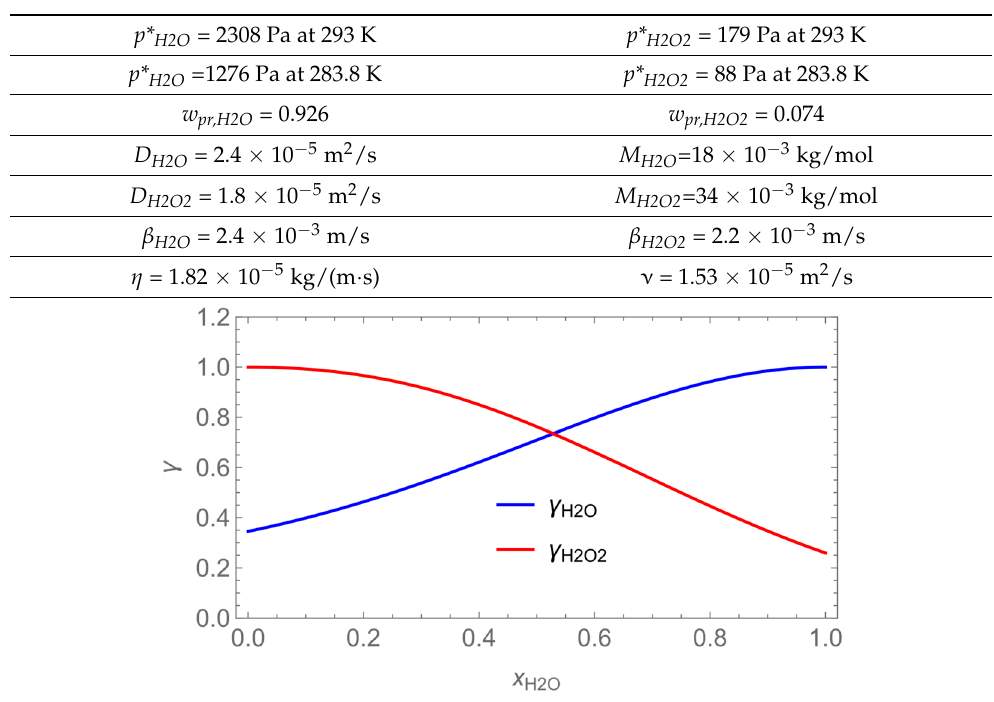
Table 3. Time-dependent modelling results for different parameters of